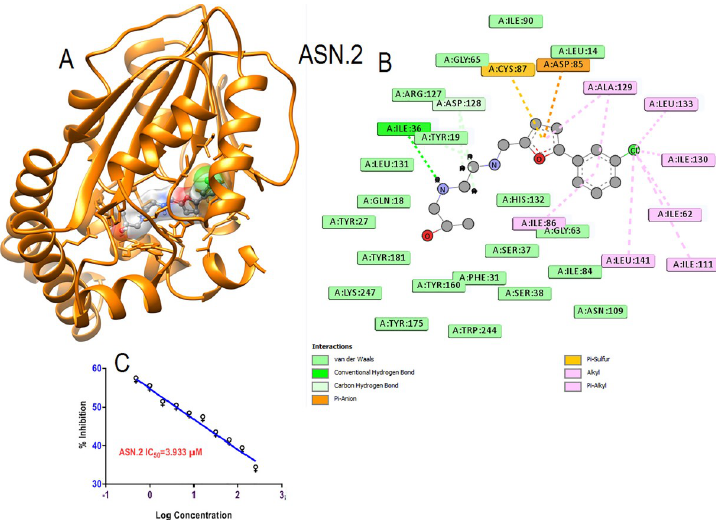
Primary hit ASN.3 showed good interaction within the binding pocket by occupying crucial amino acids (Fig 7A).The oxygen of furan heterocyclic ring formed hydrogen bonds with cru- cial amino acids Tyr19 for binding with substrate for catalyzing the function. Vander wall inter- action formed with His132, Tyr 181, Lys 247, Arg 179 and Hydrophobic interaction by furan ring through π -alkyl bonding with Tyr 160 crucial amino acids binding of substrate and for cata- lytic dyad which may be the reason of good inhibition of schizonts at low micromolar concen- tration (Fig 7B). The good schizonticidal activity at 3.21 μ M low micromolar concentration may